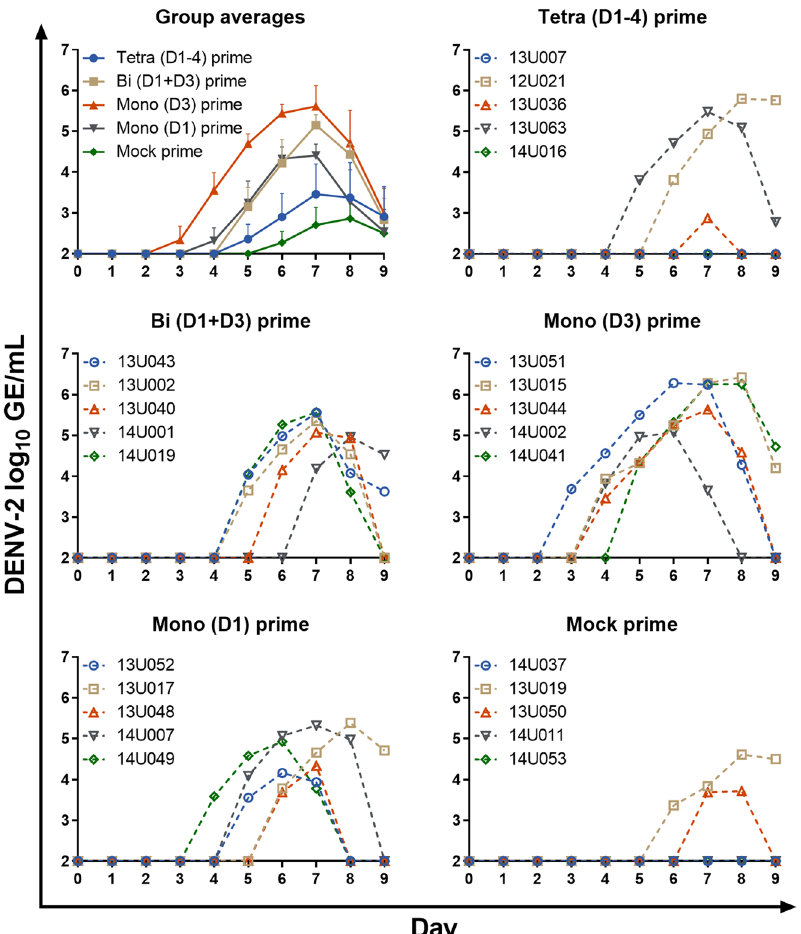
Fig. 4 Viremia of DENV-2 live-attenuated vaccine virus. Sera from days 0 – 9 post-LAV boost were tested by qRT-PCR for replication of the DENV-1 – 4 vaccine viruses. Only replication of DENV-2 was detectable. Data are presented as log 10 -transformed genome equivalents (GE)/mL. Both group geometric means and data for individual animals within each group are shown. Data were analyzed using a mixed-effects model with Geisser – Greenhouse correction and Dunnett ’ s multiple comparisons test. Error bars show the standard error of the means.